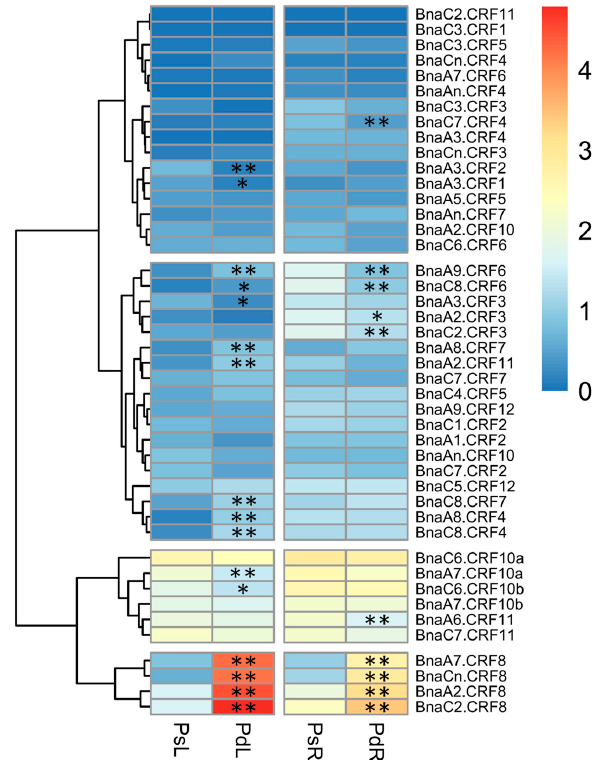
Figure3. Expressionprofilesofthe CRF genefamilyinresponsetophosphorus(P)stressin Brassicanapus . Shoots and roots of P stress-treated plants were sampled for RNA-seq. The fragments per kilobase of exon per million mapped reads (FPKM) values of the 44 BnaCRF s were extracted and were converted into the logarithmic values. PsL: P-su ffi cient leaves; PdL: P-deficient leaves; PsR: P-su ffi cient roots; PdR: P-deficient roots. Asterisks indicate significant di ff erences at * p < 0.05 and ** p <